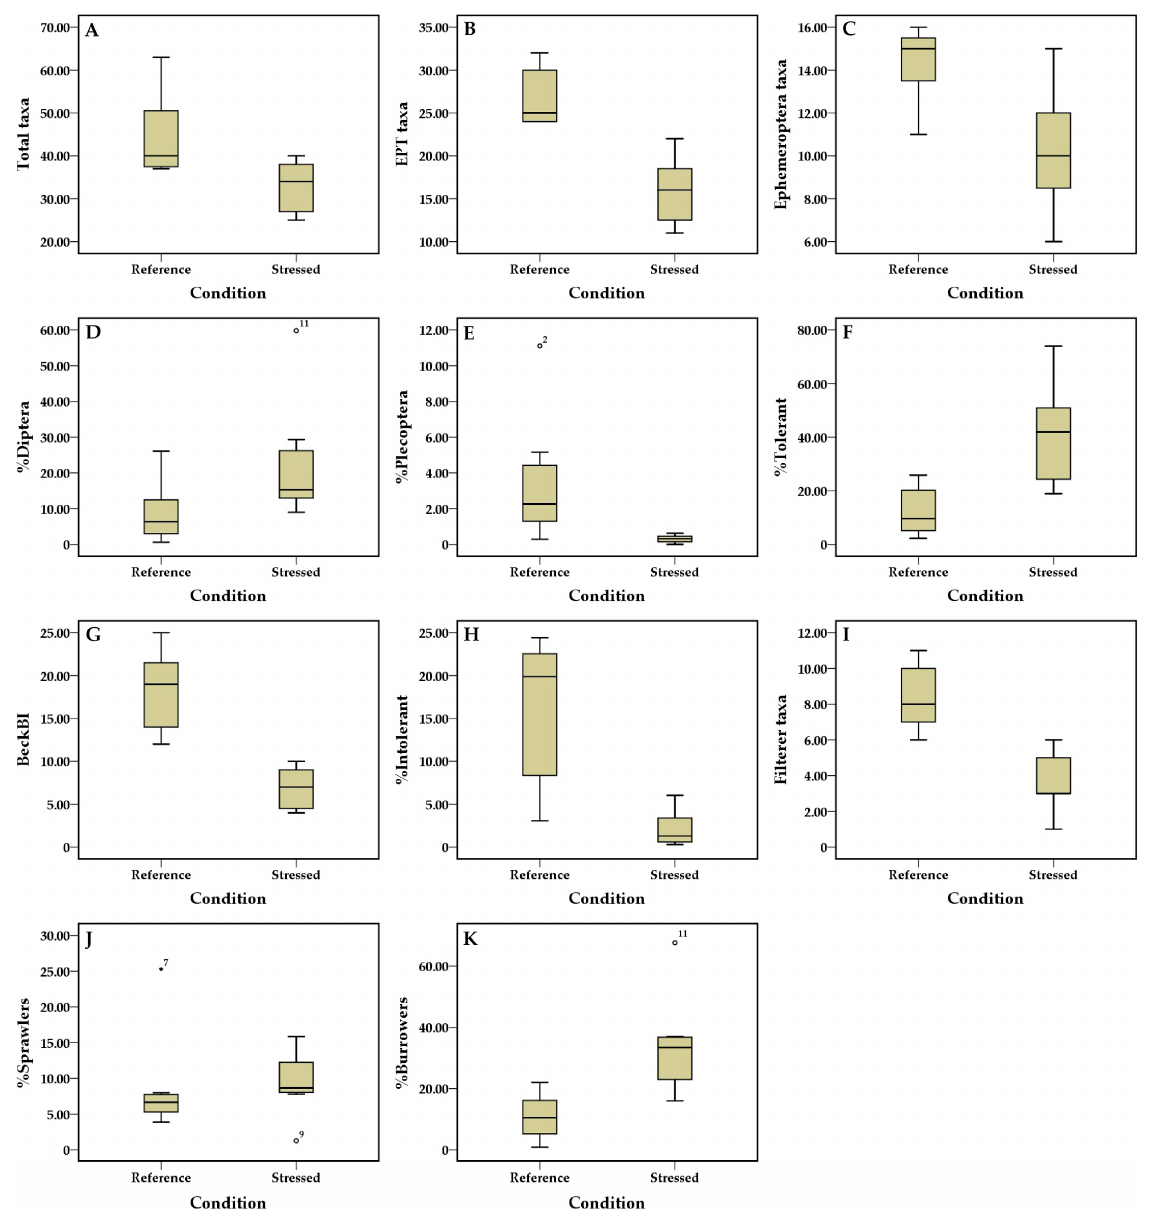
Figure 4. Box-and-whisker plots for each of the 11 core metrics sensitive to discrimination between reference and stressed sites for MMI development. ( A ) Total taxa, ( B ) EPT taxa, ( C ) Ephemeroptera taxa, ( D ) %Diptera, ( E ) %Plecoptera, ( F ) %Tolerant, ( G ) BeckBI, ( H ) %Intolerant, ( I ) Filterer taxa, ( J ) %Sprawlers, ( K ) %Burrowers. Table 5. Thirty-five candidate metrics selected for the development of MMI and their predicted response to disturbance or pollution, discrimination power score, and DE value. Metrics that met or did not meet the test criteria are expressed as symbols (/) and (-), respectively.